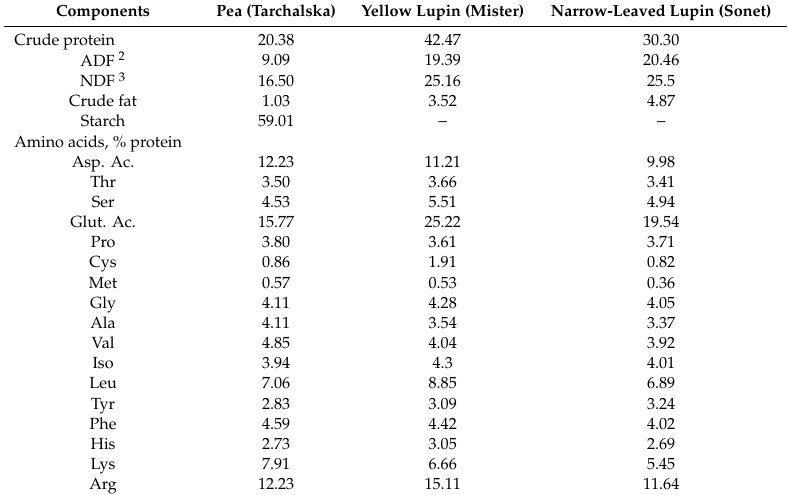
Table 1. Chemical compositions of legume seeds (% of dry matter) 1